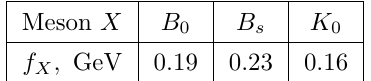
Table 14 . Values of meson decay constants. We use [92] and references